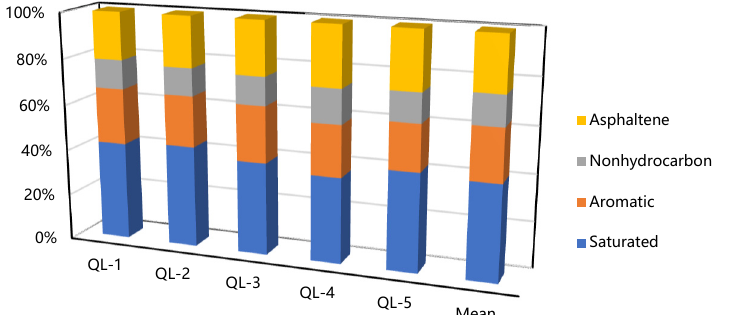
Figure 8. Group components in bitumen samples from Qinglong paleo-oil reservoir (Data from [38]).